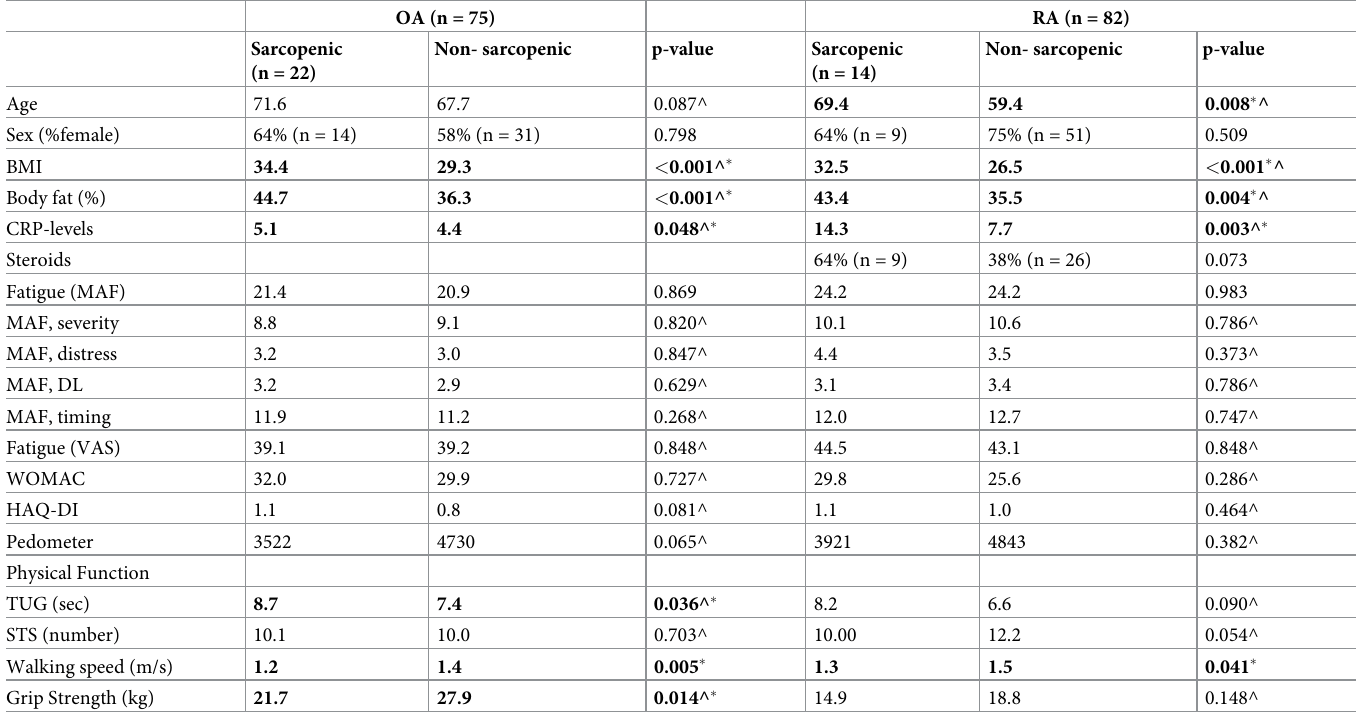
Table 2. Comparison between variables in relation to the presence of sarcopenia in OA and